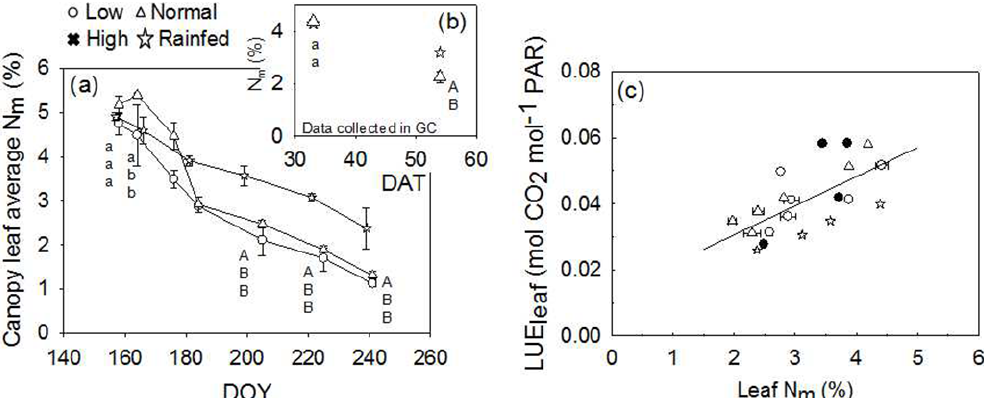
Figure 4. Seasonal courses of leaf nitrogen content (N m ) in (a) the PD low-, normal-, and high-nutrient groups, and in the RF rice in the field, and (b) in a controlled growth chamber. (c) Correlation between leaf light use efficiency (LUE leaf ) and N m crossing the PD and RF rice. Mean ± SD, n = 3 to 6. Statistic analysis showed significance at the 0.05 level (small letters) and at the 0.01 level (capital letters). DOY: day of year; DAT: day after transplanting; PD: paddy; RF: rainfed; GC: growth